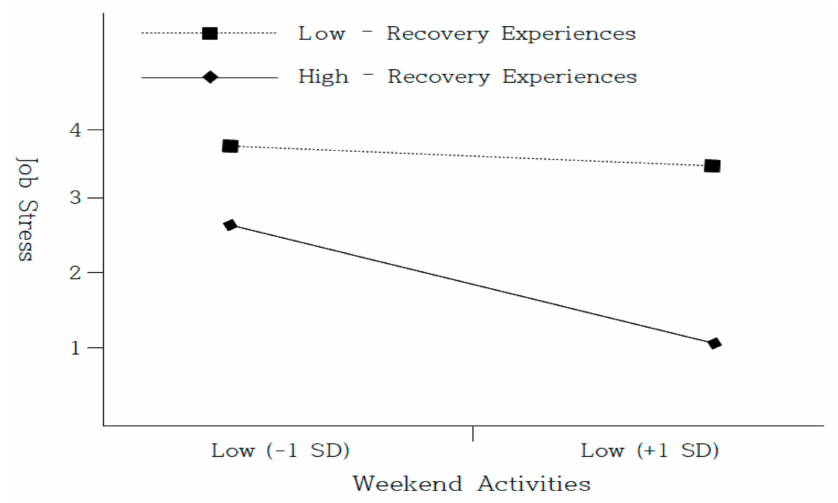
Figure 2. Moderating e ff ect of recovery experiences on the relationship between weekend activities and job